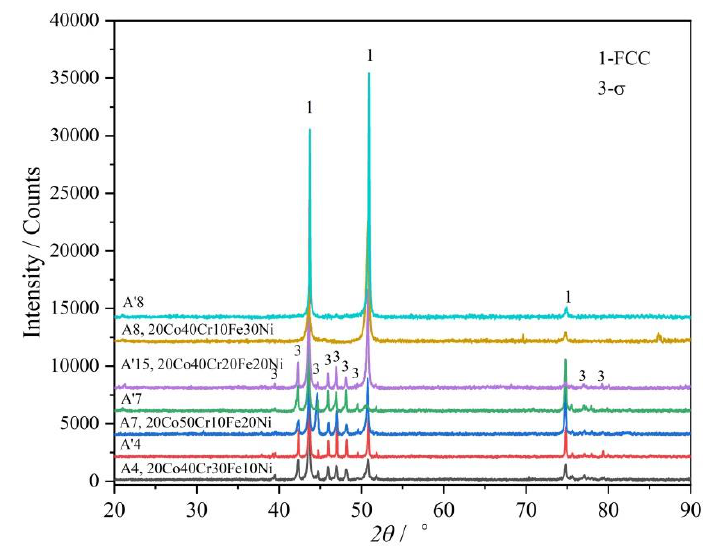
Figure 4. XRD patterns of the alloys A4, A7 and A8 in as-cast and 1000 °C annealed states and the alloy A’15 in 1000 °C annealed state. FCC and σ were found in these alloys.